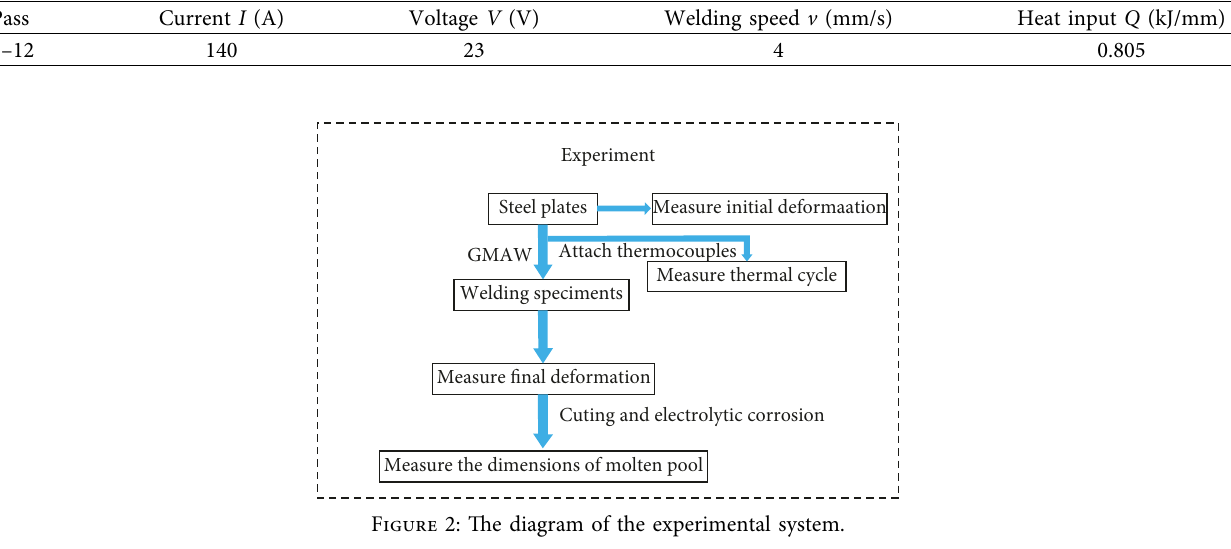
Table 3: Welding parameters.